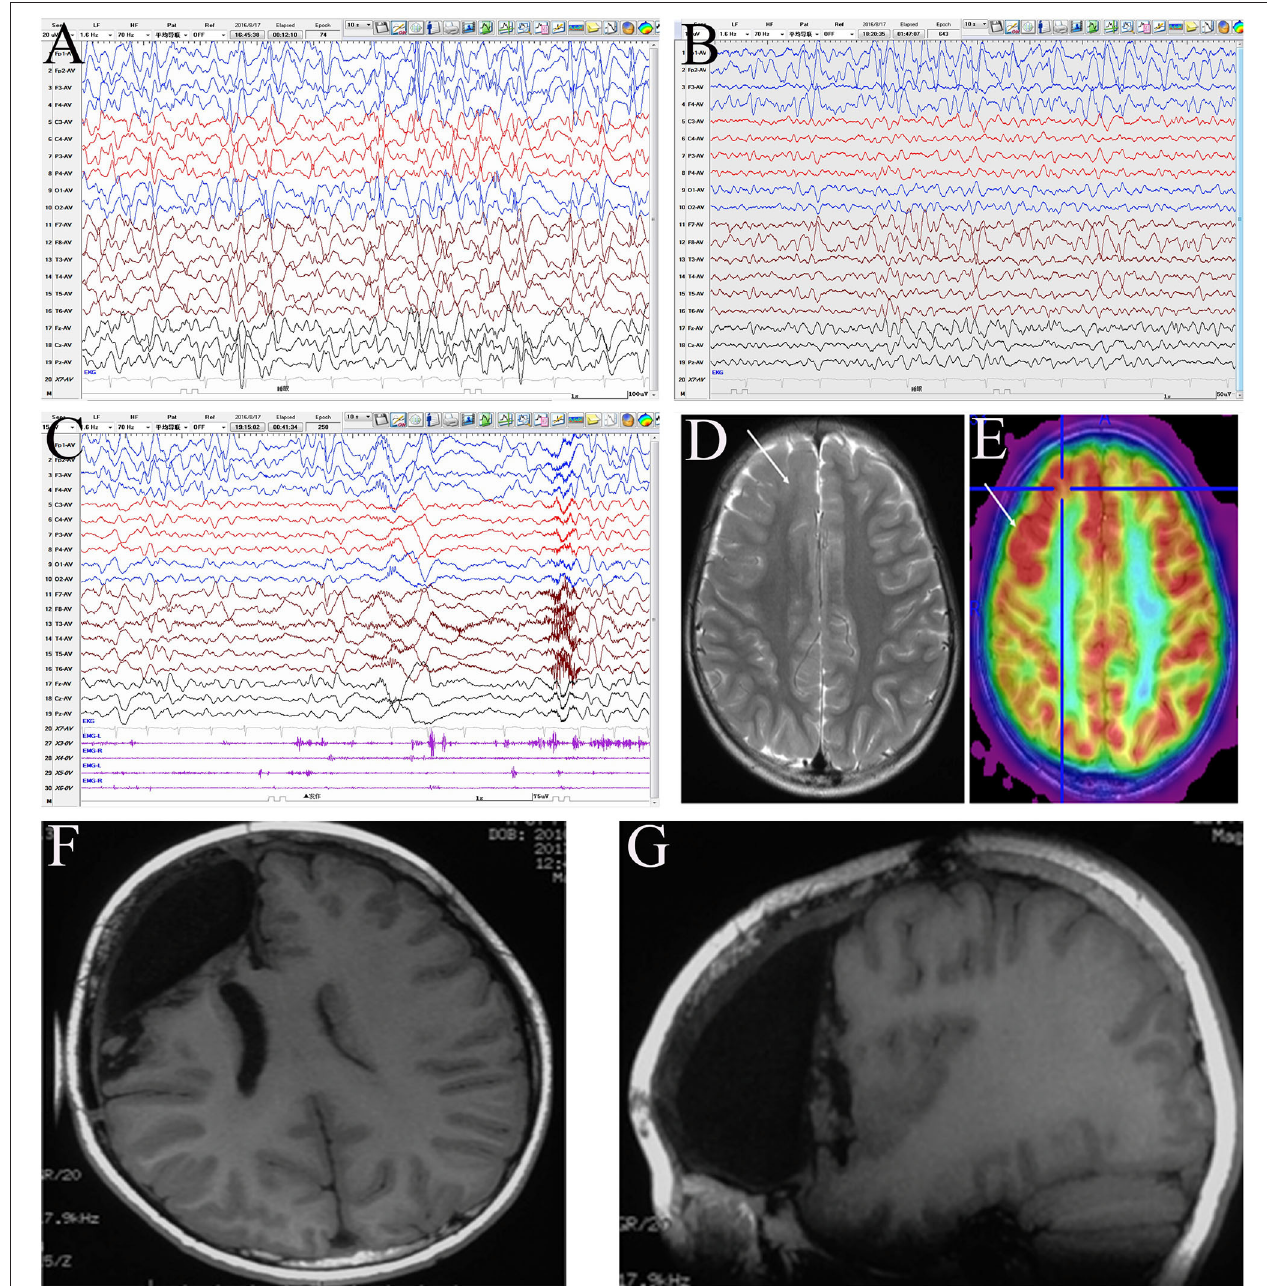
FIGURE 2 | Evaluation of a male patient, 5 years old with onset age at 1 year and 6 months and clustered asymmetric epileptic spasm, which was obvious in the left upper limb. The patient had been prescribed several anti-seizure medicines, including adrenocorticotropic hormone, valproic acid, topiramate, and levetiracetam, with no success. The patient had mental and motor developmental delay and no obvious hemiplegia. Interictal electroencephalogram (EEG): hypsarrhythmia (A) , with intermittent right frontal regional continuous discharge (FP2, F4, and F8) (B) ; ictal EEG: fast rhythm dominated on the right hemisphere (C) . MRI: focal cortical dysplasia (FCD) in the right frontal lobe (D) , with boundary-clear focal hypermetabolism on positron emission tomography (PET) (E) . According to the presurgery evaluation and intraoperative electrocorticography, the resection scope included the right prefrontal lobe, anterior cingulate cortex, frontal central operculum, and anterior insula (F,G) . Pathology: a few dysmorphic neurons (FCD IIA) in the ACC and malformation of cortical development in other areas. The patient has been seizure-free for 3 years and shows mild mental and motor progression.